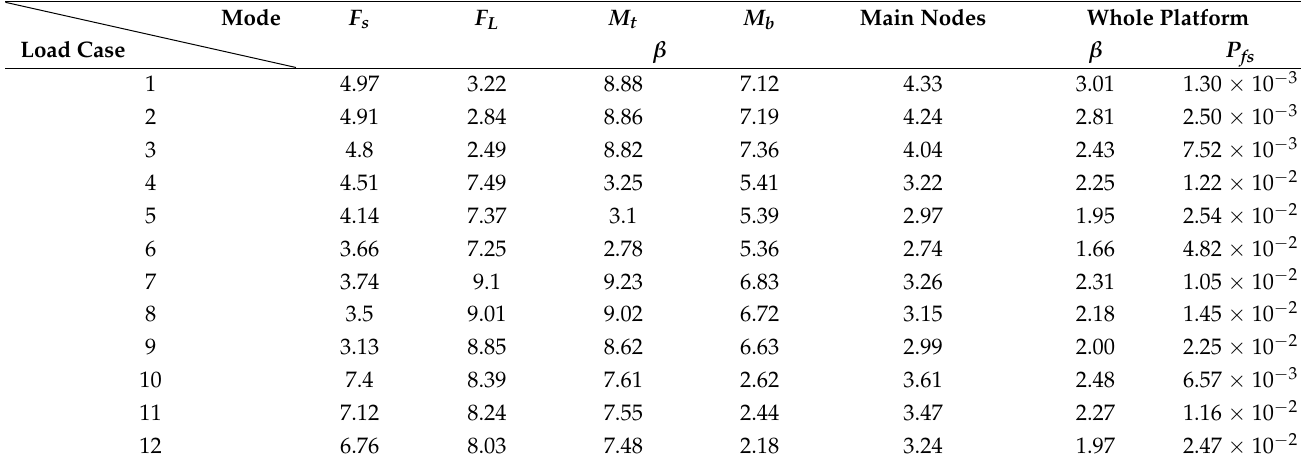
Table 11. System reliability of the object structure for each load